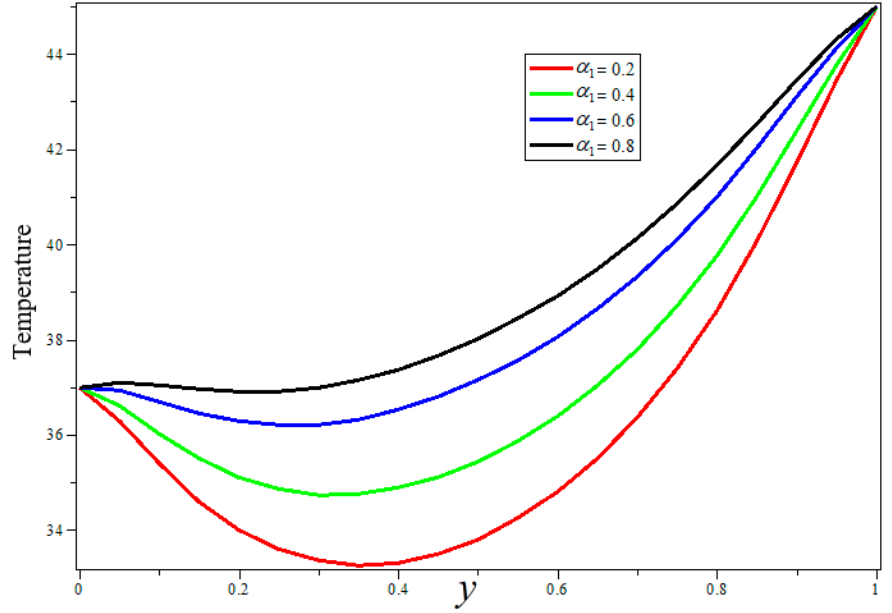
Figure 5. The influence of blood thermal conductivity on the temperature field during tumor hyperthermia.